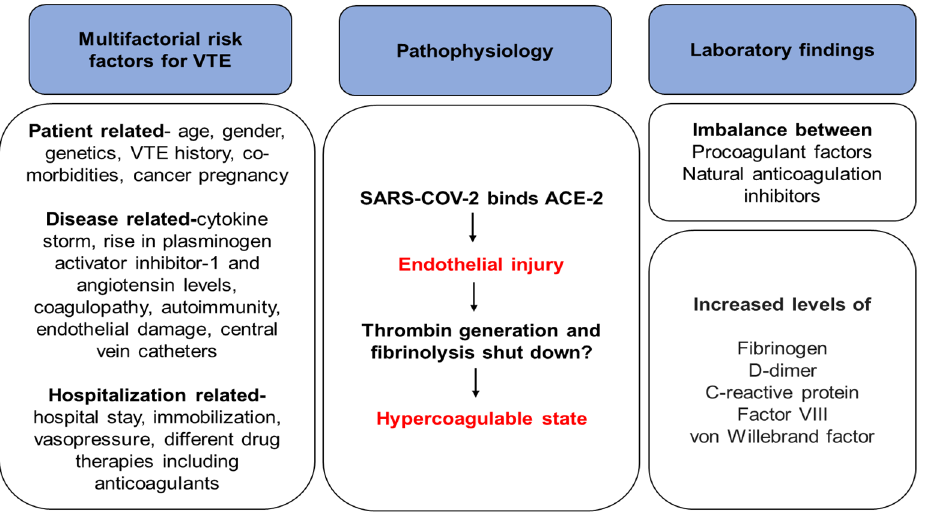
Figure 1. Associated risk factors and pathophysiology of VTE [33–35]. ACE-2: angiotensin-converting enzyme 2; SARS-CoV-2: severe acute respiratory syndrome coronavirus 2; VTE, venous thromboembolism.